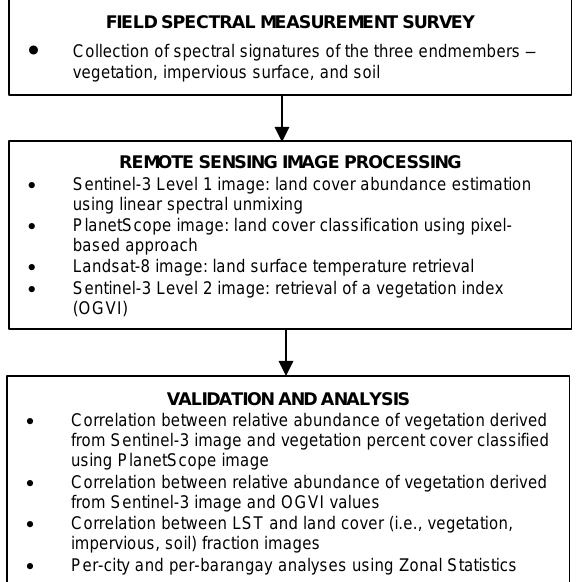
Figure 1. Flowchart of the methodology used in this study